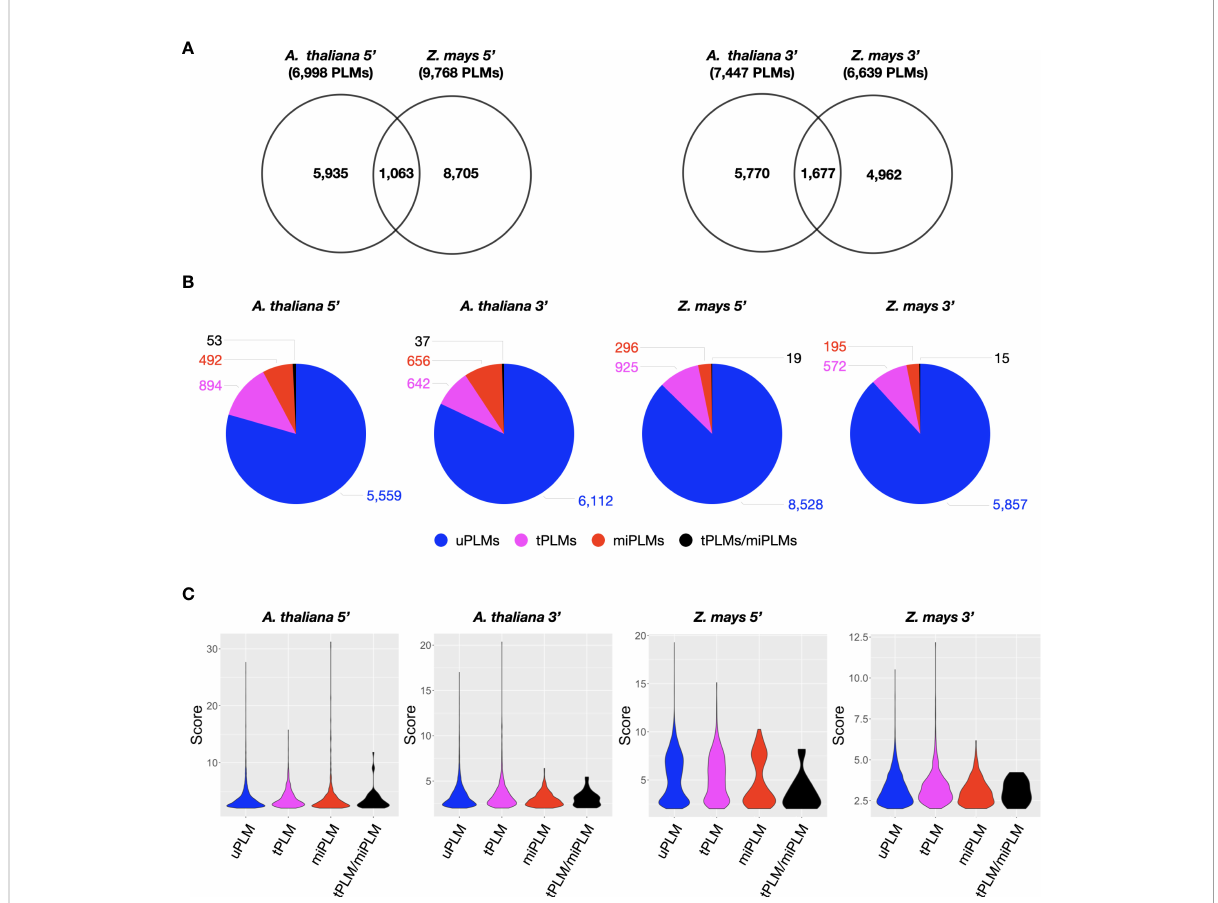
FIGURE 2 Characterization of PLM content in gene-proximal regions of A. thaliana and Z. mays. (A) Venn diagram showing the extent of overlap between 5 ’ - or 3 ’ -PLMs of A. thaliana and Z. mays . (B) Dissection of PLM types identi fi ed in the 5 ’ - or 3 ’ -gene-proximal region of A. thaliana and Z. mays. (C) Violin plot of PLM scores according to the PLM types in the 5 ’ - or 3 ’ -gene-proximal region of A. thaliana and Z.